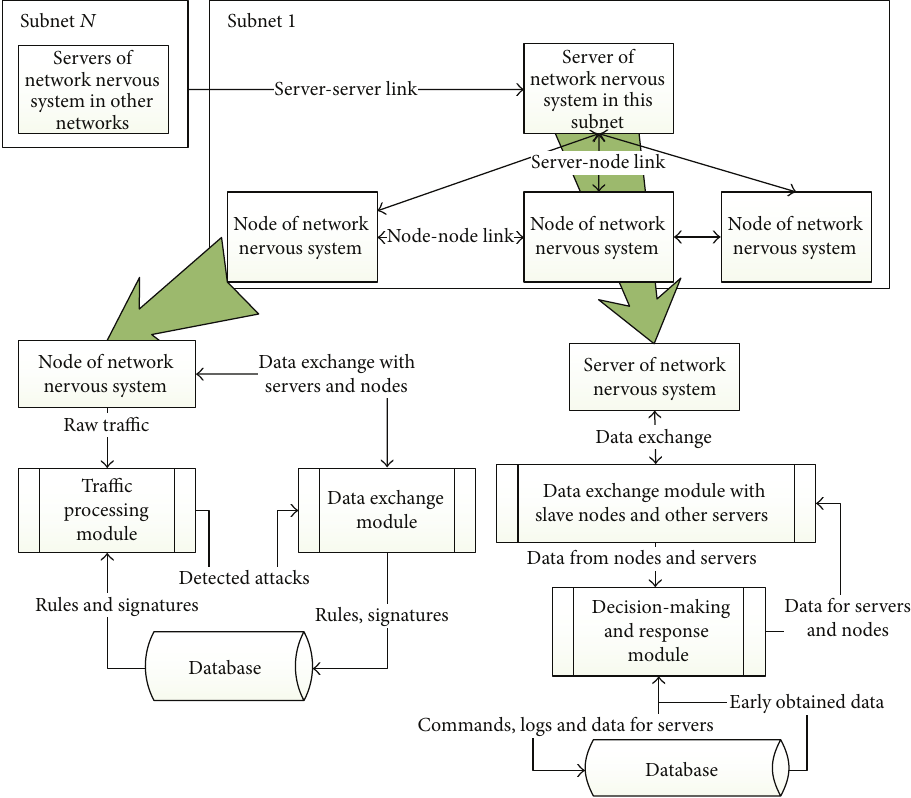
Figure 1: Common structural representation of the “network nervous